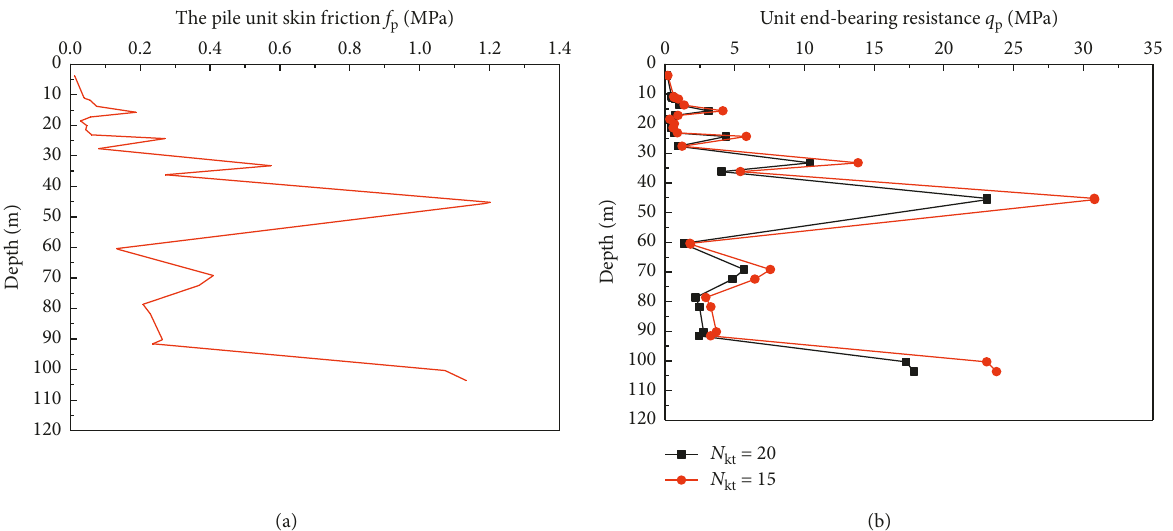
Figure 13: Calculated results for the unit end-bearing resistance ( q